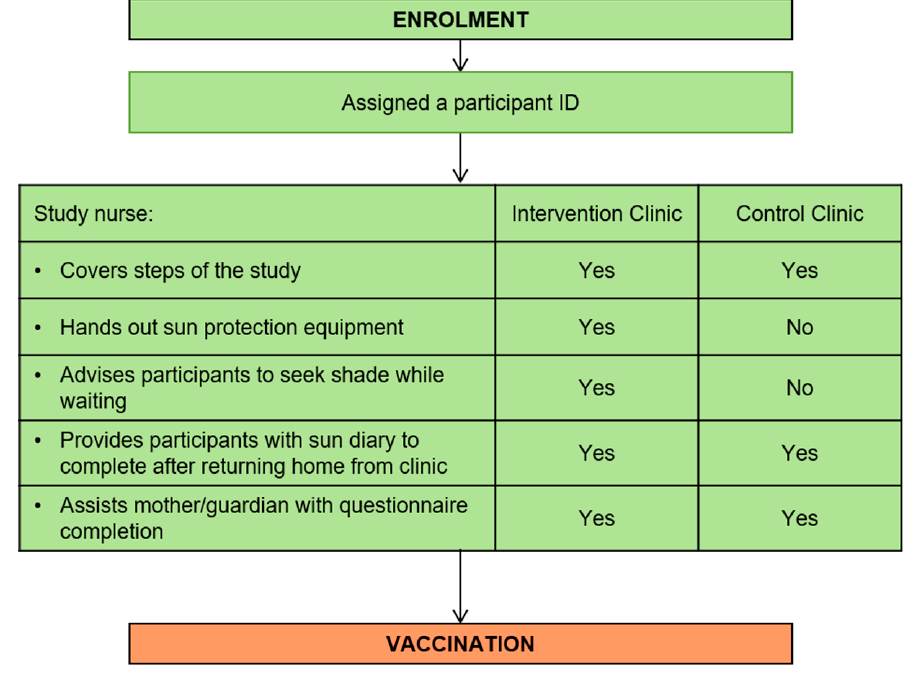
Figure 3. Recruitment stage flow chart.